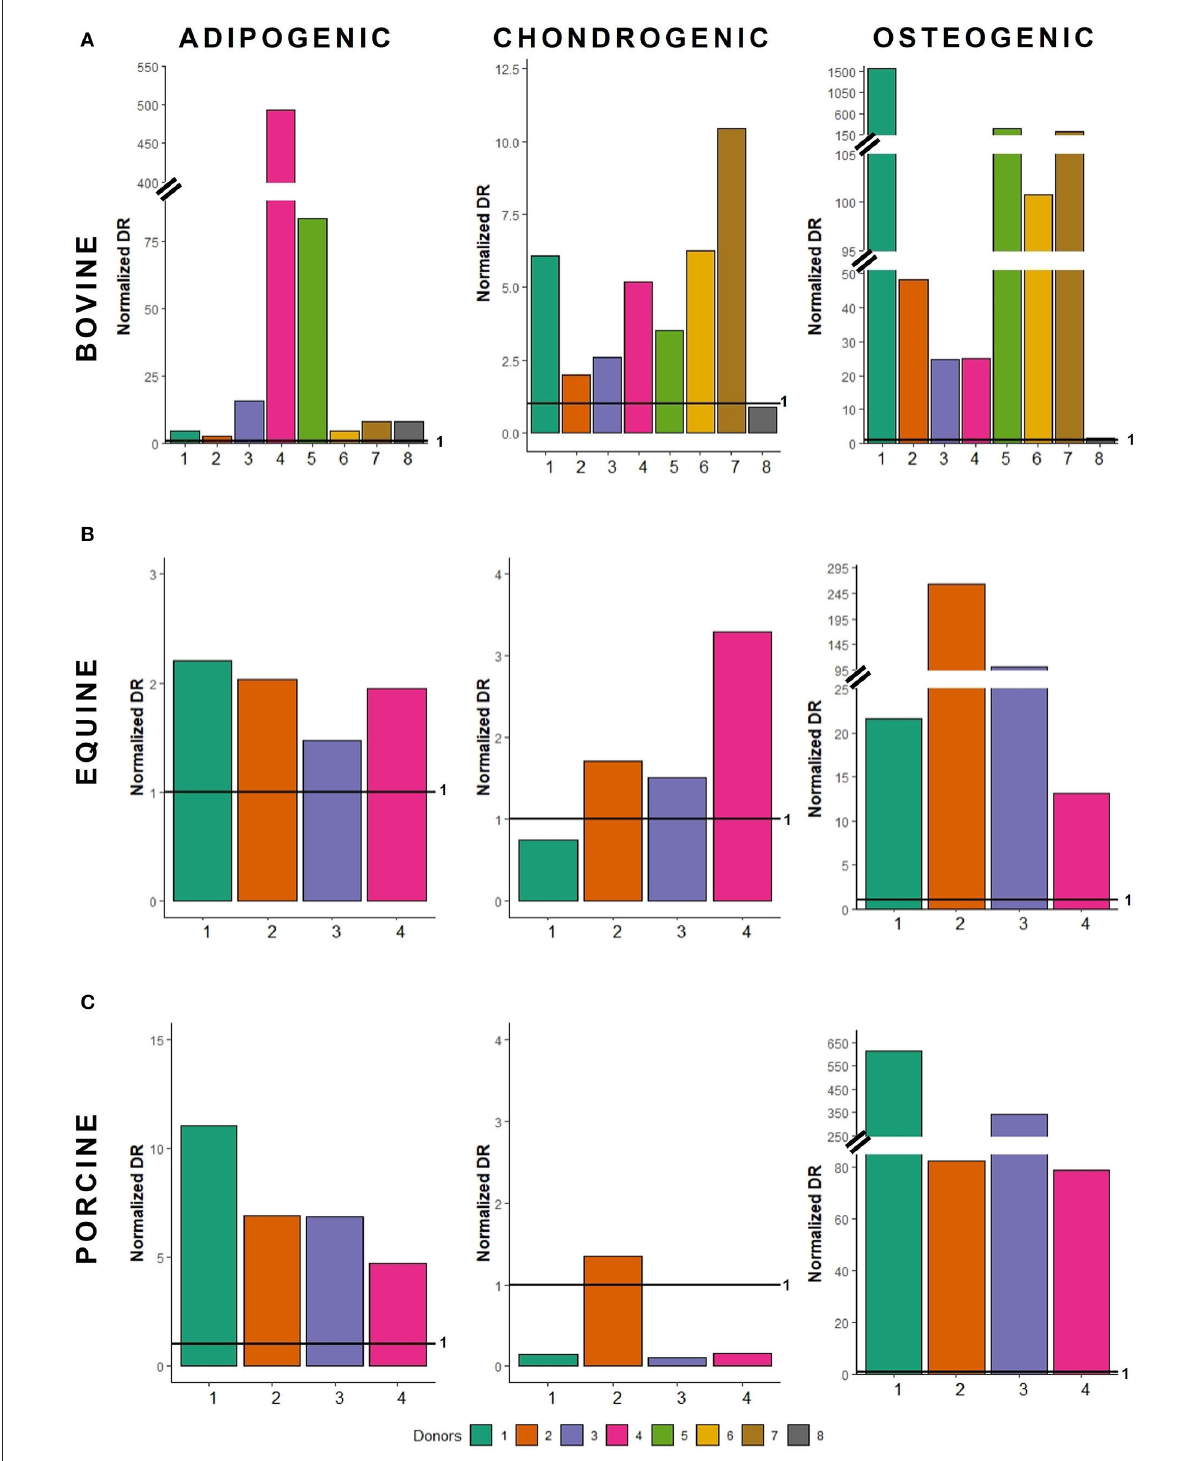
FIGURE5 Normalized differentiation ratios of (A) bovine MSCs, (B) equine MSCs, and (C) porcine MSCs. For each donor, the normalized differentiation ratio (DR) is shown. The latter is calculated by dividing the mean DR of differentiated wells by the mean value of the non-induced controls. When this ratio is less than 1, less differentiation is observed when compared to non-induced controls; when the normalized DR is above 1, a higher differentiation is